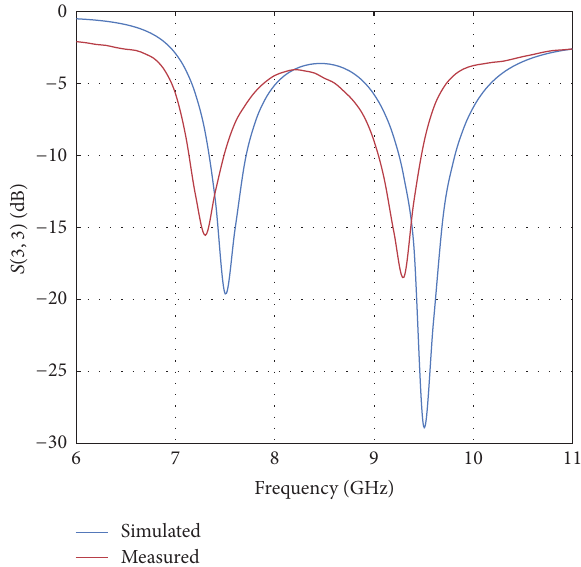
Figure 21: Comparison of simulated and measured reflection coefficients of the second NB antenna.